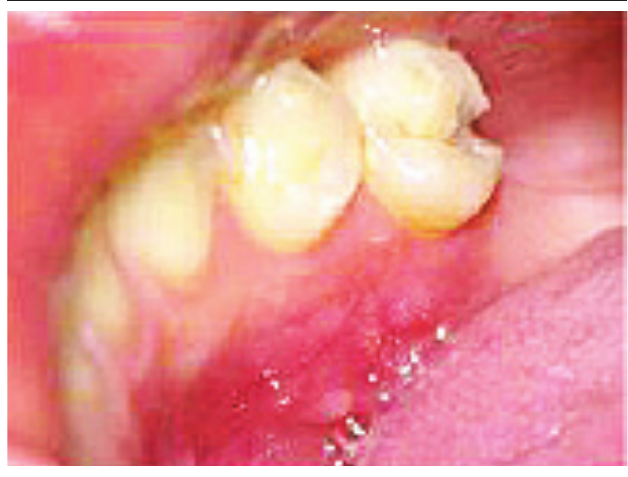
figurE 5 − Postoperative (two